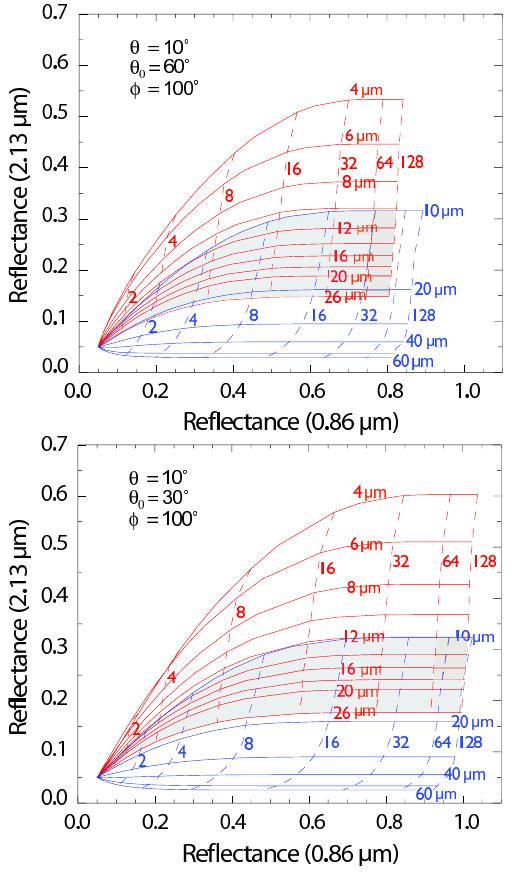
Fig. 5. Simulation for two solar and viewing geometries of the 2.1µm against 865 nm reflectances for an ice (blue) and liquid (red) cloud of varying optical thickness and effective radius. Overlapping zone between the ice and liquid retrieval spaces (shaded region) cor- responds to situation where a SWIR vs. VIS/NIR reflectance metric can not provide unambiguous phase information.